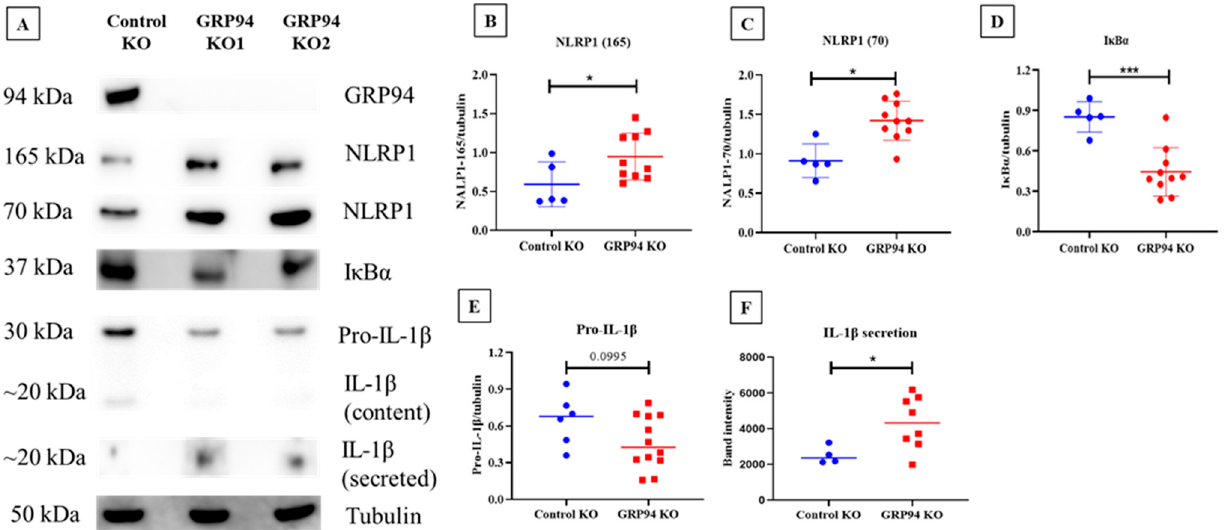
Figure 7. Western blot analysis for the expression of NLRP1, I κ B α , and IL-1 β in GRP94 KO INS-1E and control KO cells. ( A ) SDS-PAGE for expression of NLRP1 (fully assembled version (165 kDa) and without LRR (70 kDa)), I κ B α , and IL-1 β in tested conditions. ( B – F ) Statistical analysis (unpaired t -test) for the expression of NLRP1, I κ B α , and pro-IL-1 β /IL-1 β , quantified and normalized to tubulin in tested conditions. n = 4–6 for different proteins of interest. ( B – E ) were generated using the ratio of quantified protein of interest to tubulin while ( F ) was generated based on quantified IL-1 β only from the supernatant from equal cell numbers cultured and volume of culturing media. * p ≤ 0.05, *** = p ≤ 0.01.